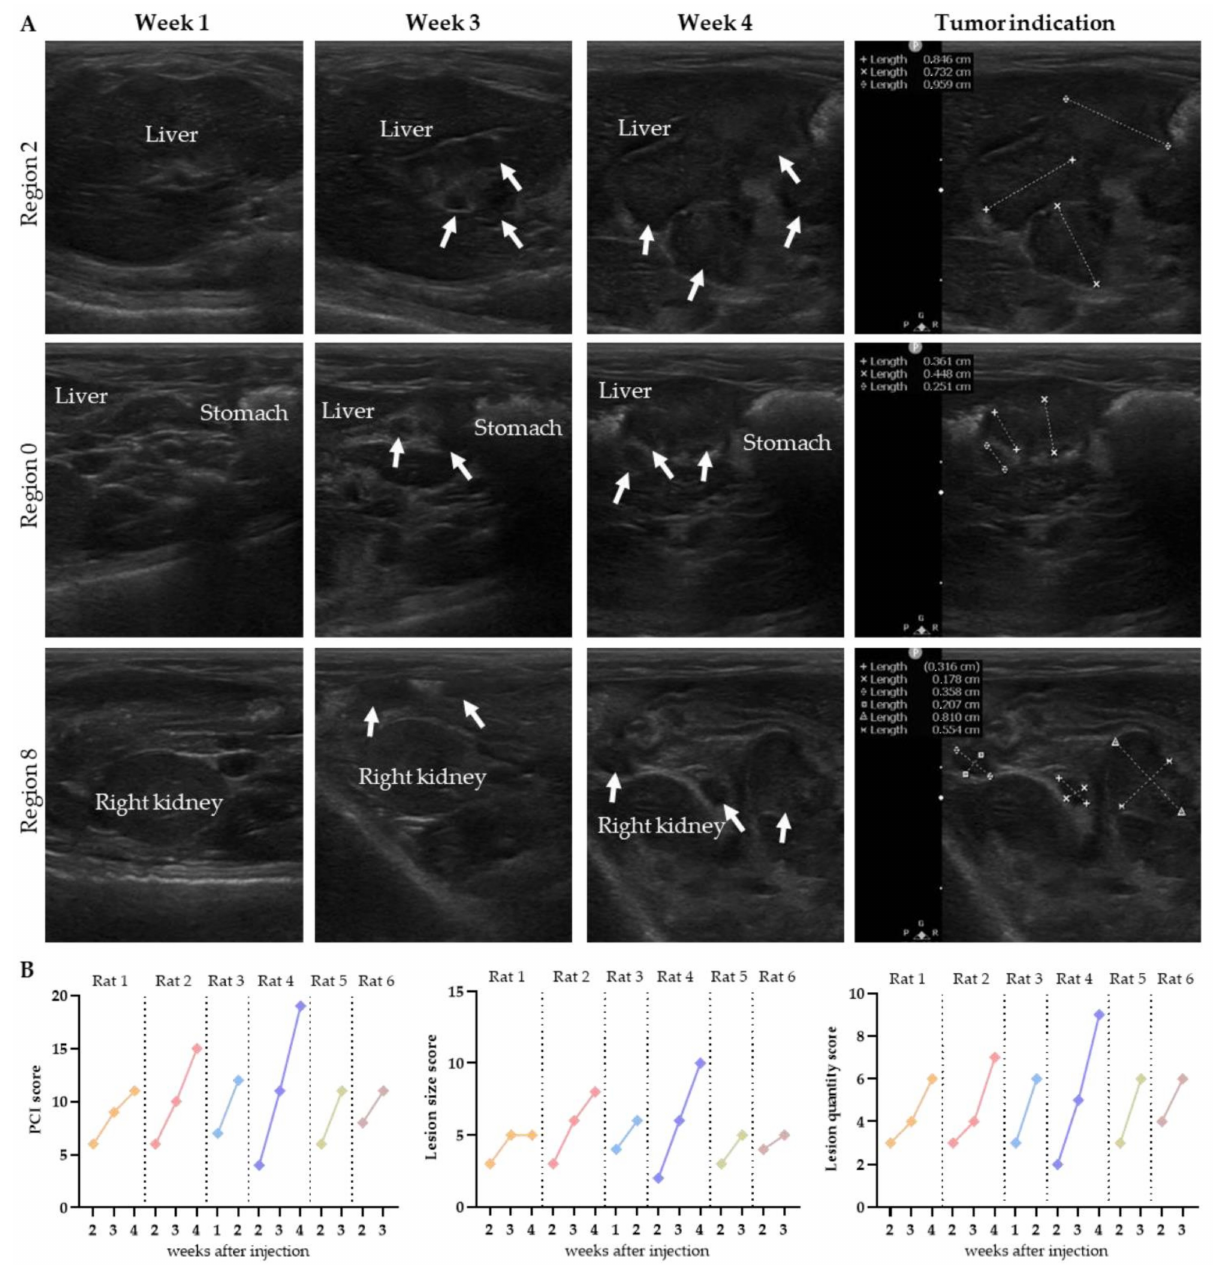
Figure 4. The tumor growth over time is presented for three regions in rat 4 ( A ). Tumor lesions are indicated with white arrows, and organs are named. The progression in total PCI, lesion size and lesion quantity over time was scored on ultrasound by observer 1 ( B